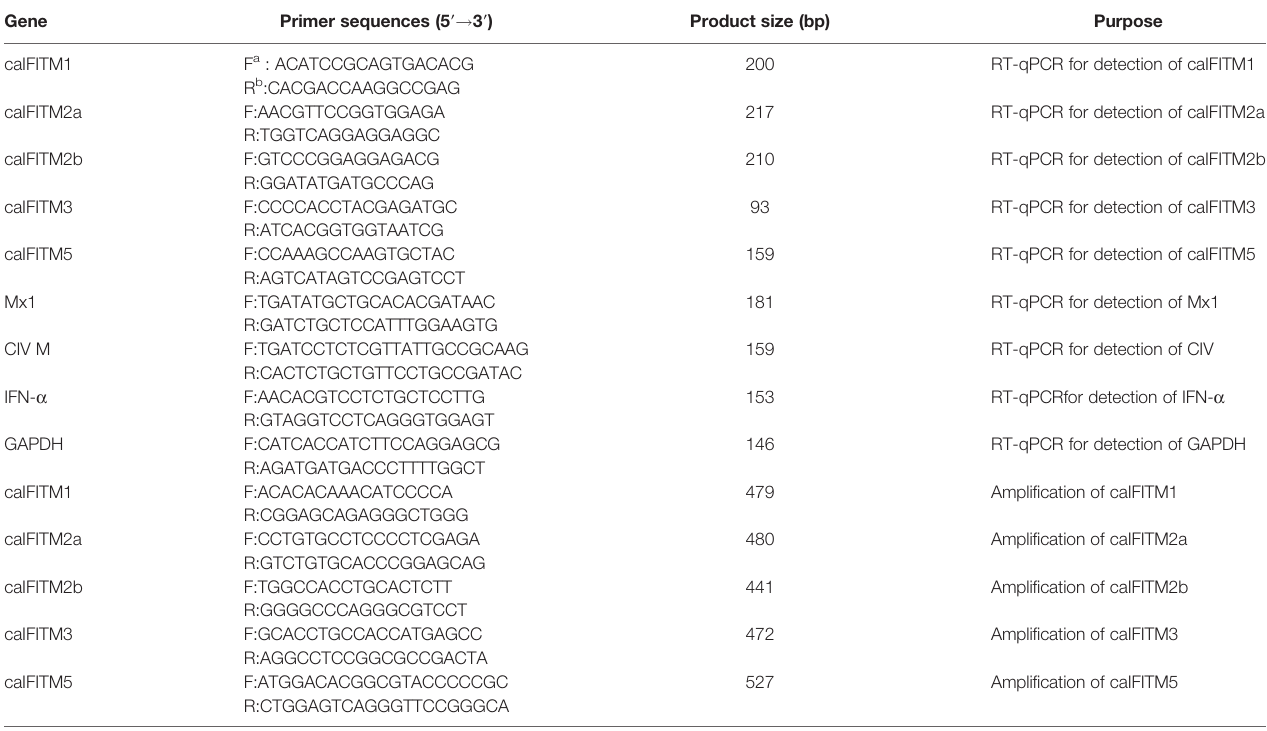
TABLE 1 | Primers used for gene cloning and RT-qPCR analysis. Gene Primer sequences (5 ′ ! 3 ′